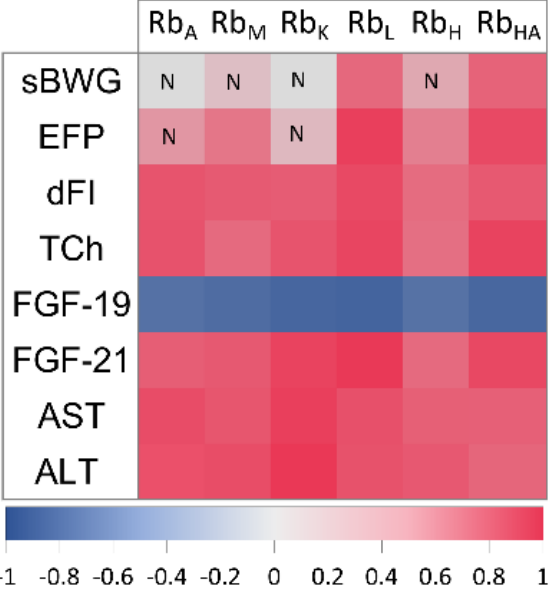
Figure 6. Pearson’s or Spearman’s correlation coefficients for relationships between rubidium (Rb) concentrations in rat organs/tissues and physiological or metabolic parameters. sBWG — specific rate of body weight gain, EFP — epididymal fat pads, dFI — daily feed intake, TCh — total cholesterol, FGF − 19 — fibroblast growth factor 19, FGF − 21- fibroblast growth factor 21, AST — liver aspartate transaminase, ALT — liver alanine transaminase, A — adipose tissue, M — muscle, K — kidney, L — liver,